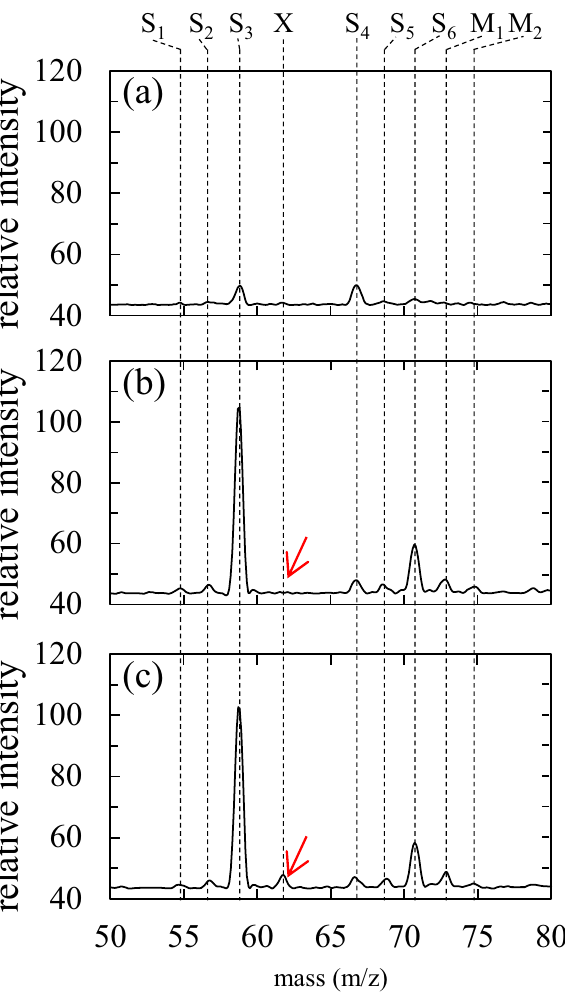
Figure 2. Typical MS spectra of ( a ) blank, and extract of 20 seeds ( b ) without plasma irradiation and ( c ) with 5 min plasma irradiation, obtained by